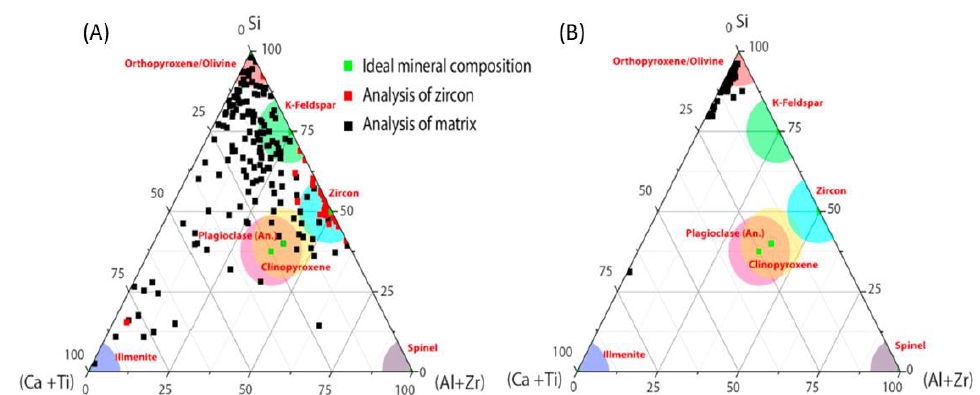
Figure 2. Ternary diagrams to visualise the minerals present in the sample: ( A ) Area containing a zircon grain on the KREEP-rich sample; ( B ) Area on the border between the KREEP-rich and regolith parts of the meteorite (Reproduced with the permission from the journal Planet. Space Sci.